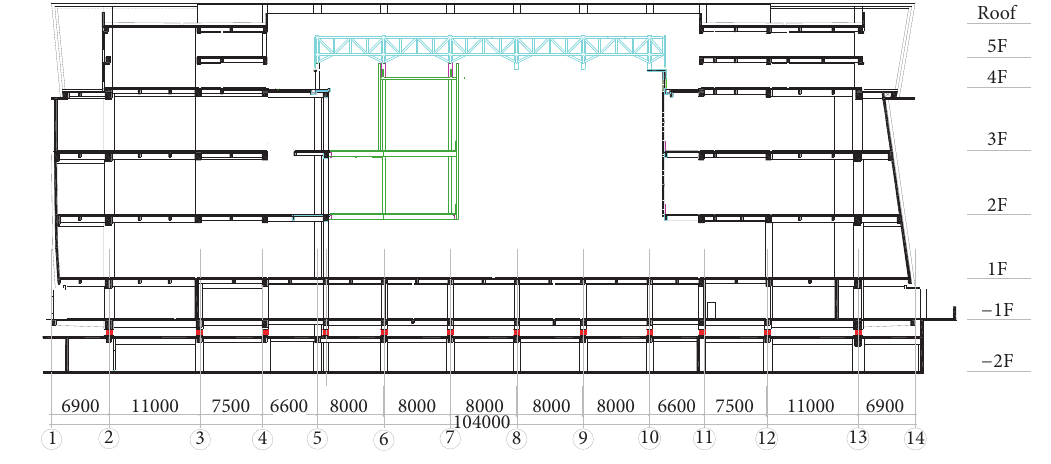
Figure 4: Structural profile (unit: mm).